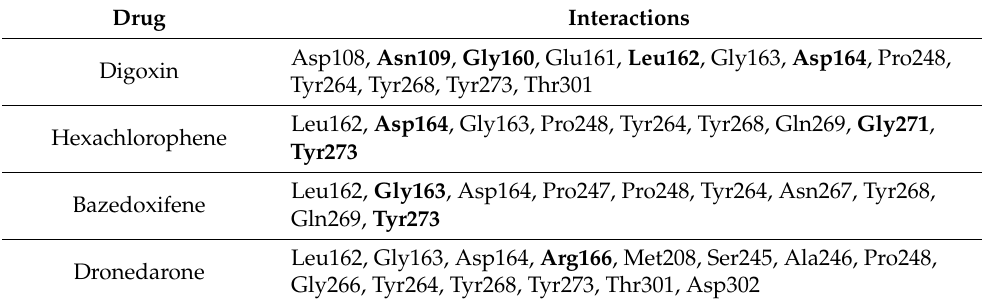
Table 5. Interactions of different drugs with